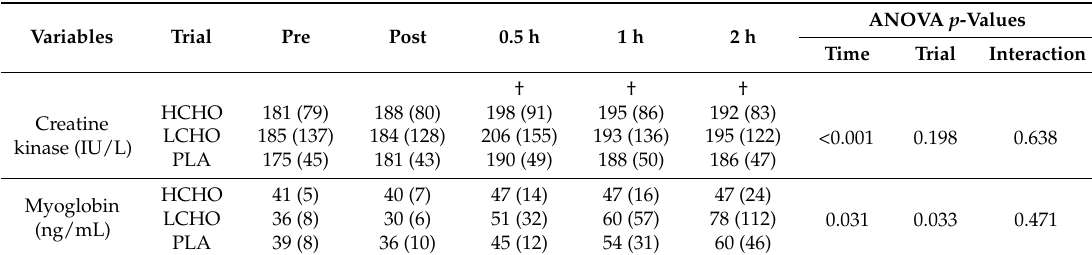
Table 2. Changes in serum concentration and enzymatic activity of indirect markers of muscle damage in response to endurance